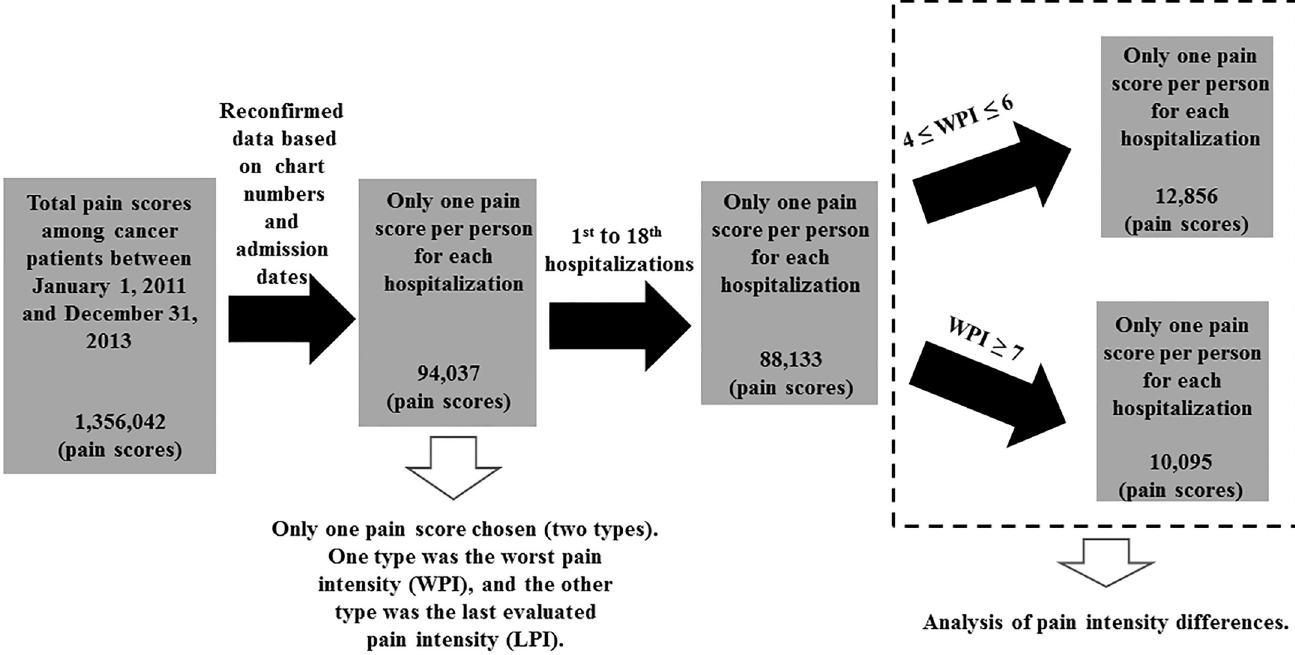
Fig 1. Retrieval of moderate and severe pain scores from the nursing information system database. In all, 1,356,042 pain scores were collected over the three-year study period. After we reconfirmed the data according to chart numbers and admission dates, the number of pain scores was reduced to 94,037. The number of hospitalizations per patient at this academic center ranged from one to 18, and 88,133 pain scores were assessed. To evaluate the PID in cancer patients with a WPI that indicated moderate or severe pain, the WPI scores were classified into the following two categories: moderate pain (4 � WPI � 6 points) and severe pain (WPI � 7